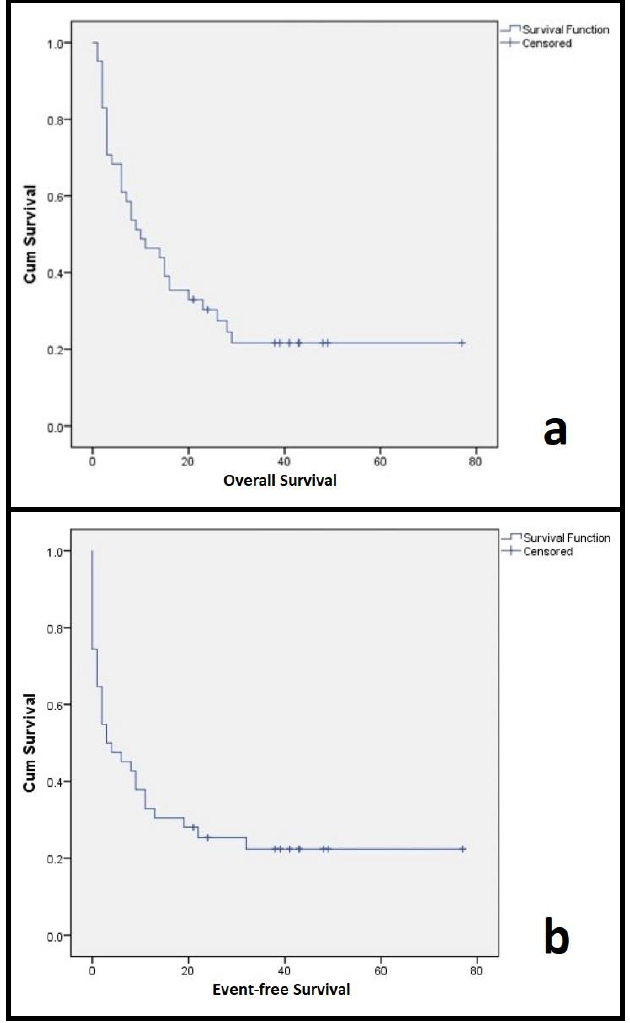
Figure 2: Kaplan- Meier curves of a) overall survival and b) event-free